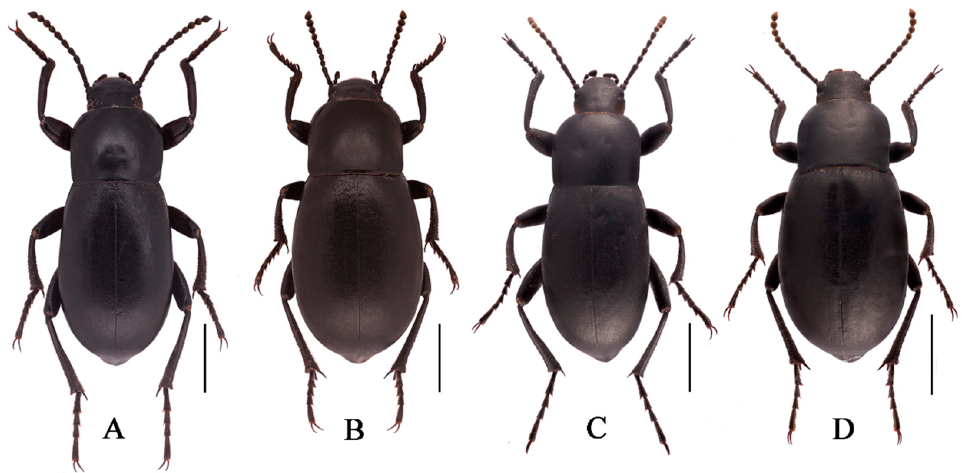
Figure 8. Habitus of N. polita sp. n. ( A ). male, holotype; ( B ). female, paratype; from Chowa, Dêgê, Sichuan, China; ( C,D ) male, female ; from Gyawa, Garzê, Sichuan, China. Scale bars: 5.0